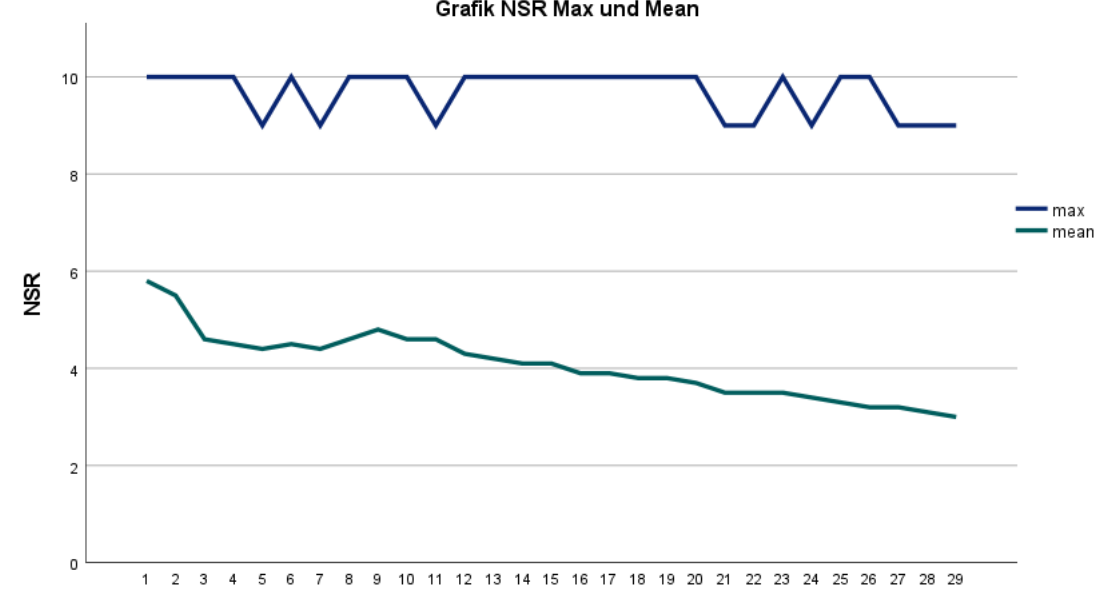
Figure 2. Graph represents the morning, lunchtime, evening, and nighttime pain on days 1 – 29 on an NRS scale.